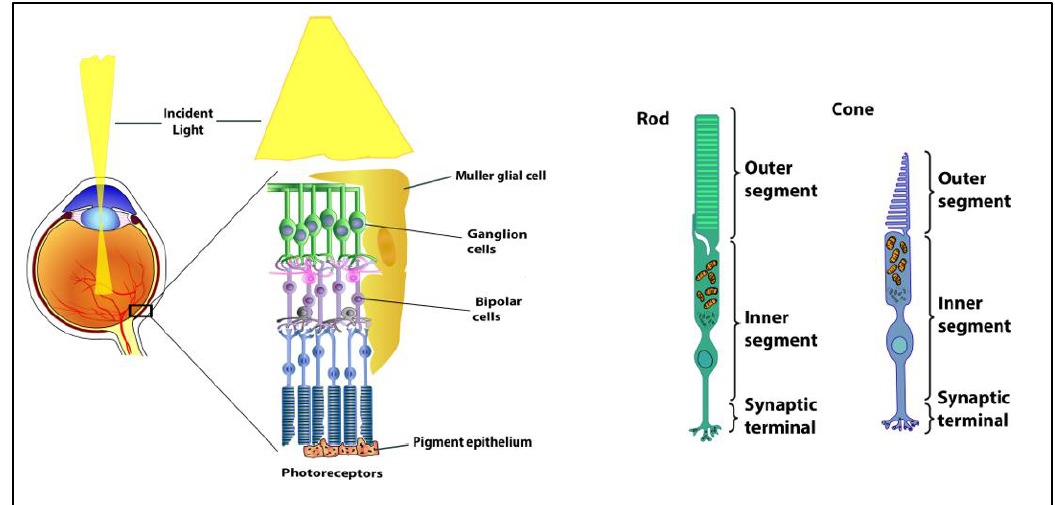
Figure 1. Anatomy of the retina and the structure of rod and cone photoreceptors.